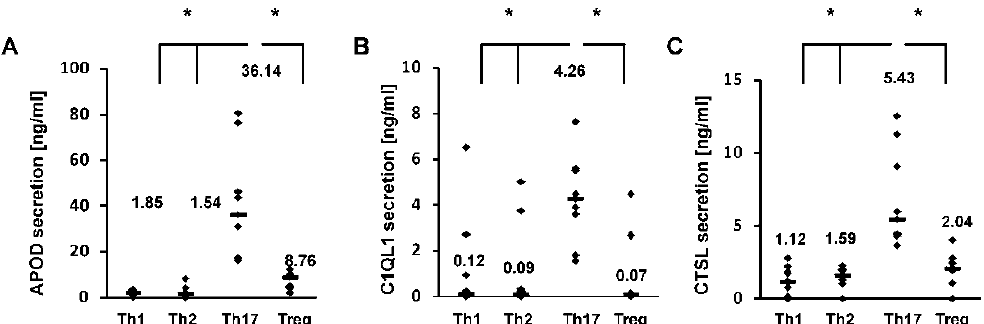
Figure 3. Results of APOD ( A ), C1QL1 ( B ), and CTSL ( C ) production determined using ELISA. The data are presented as statistical dot plots with the median value (bars) from nine independent experiments performed using cultures from nine different donors ( n = 9). An asterisk indicates a statistically significant difference at p < 0.05. Statistical analysis was performed using Friedman repeated measures ANOVA on ranks followed by Dunn’s post hoc test.